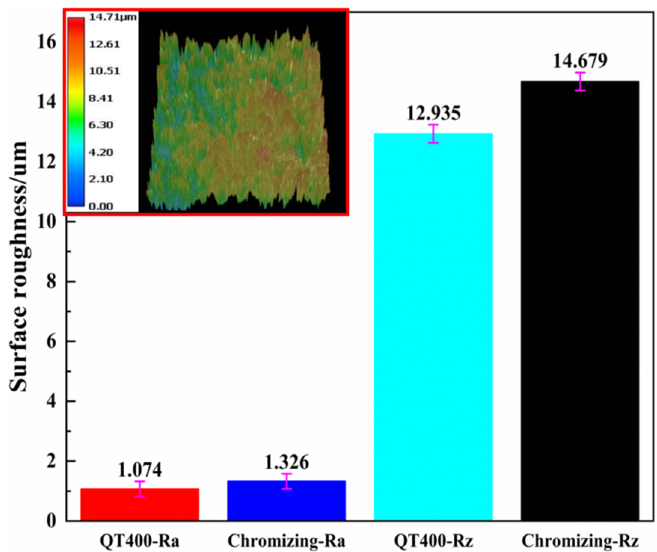
Figure 4. Surface roughness of QT400 and chromed samples.